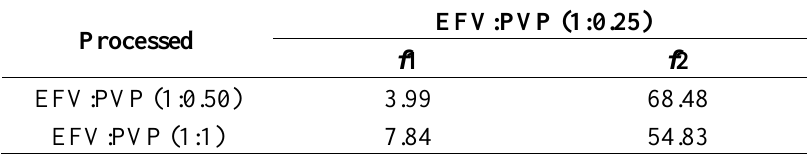
Table 5. Values of f 1 and f 2 found for EFV:PVP processed